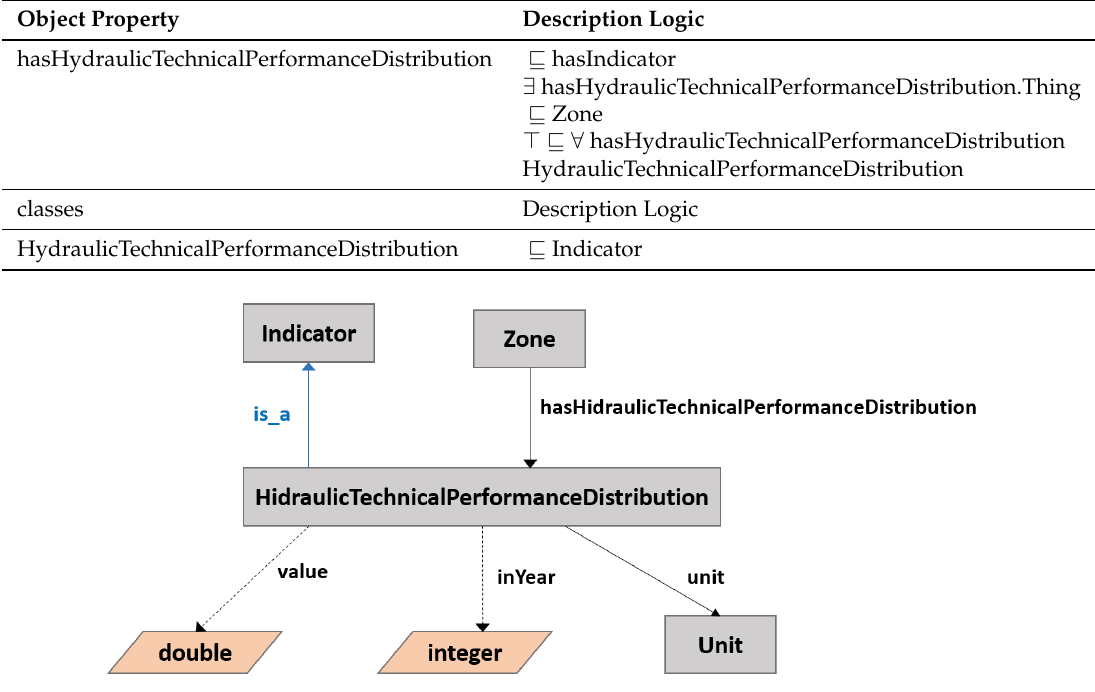
Figure 4. Relations between Zones and Indicators. Example of “HydraulicTechnicalPerformance Distribution”